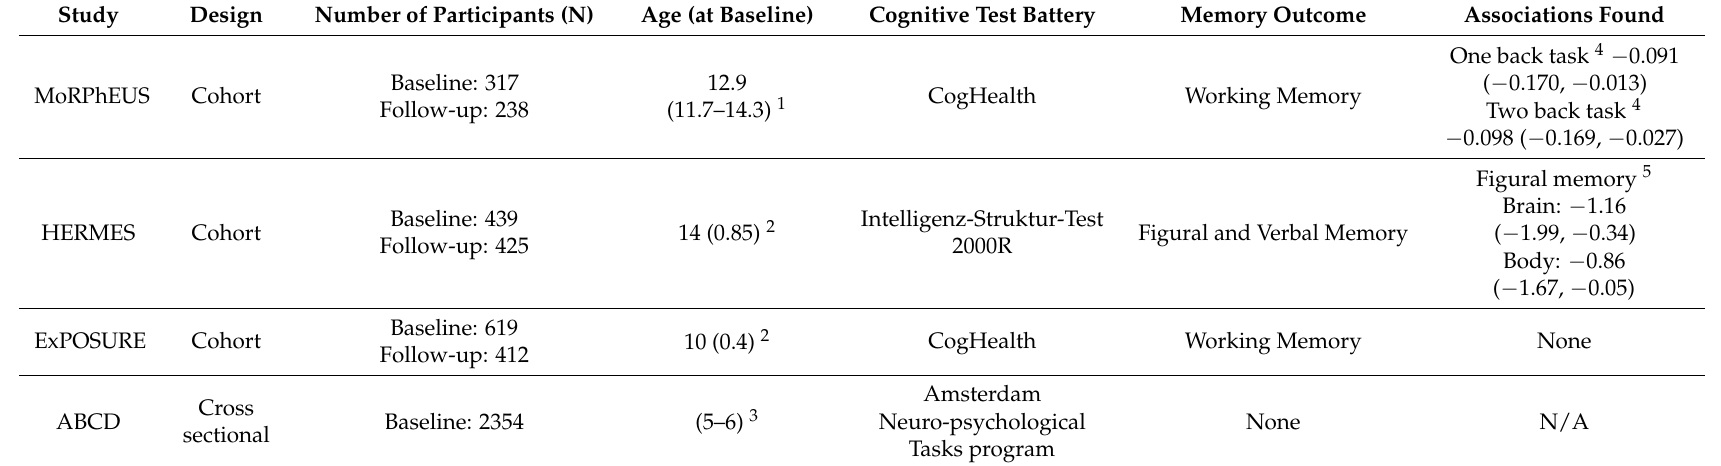
Table 2. Summary of studies investigating RF-EMR and cognitive